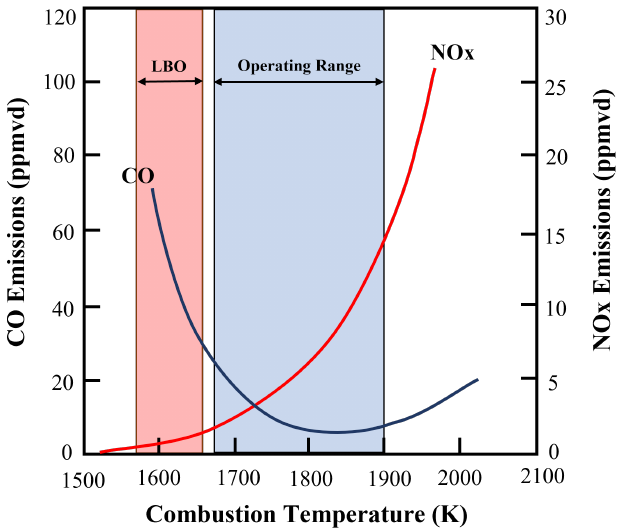
Figure 19. NOx and CO emission to characterize LBO